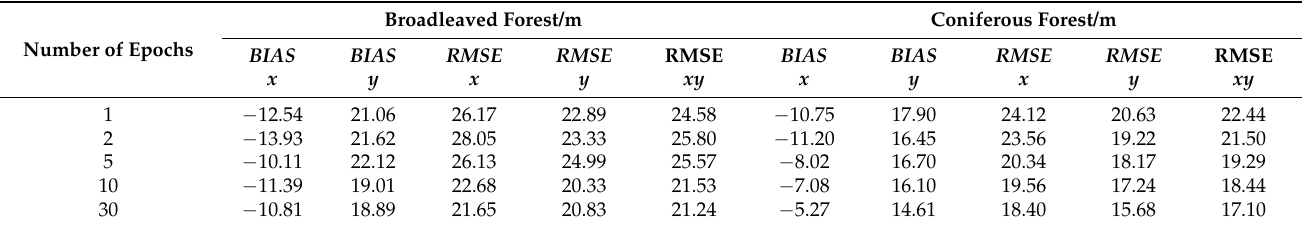
Table 5. Accuracy evaluation of single-point positioning error in the coniferous forest and broadleaf forest.